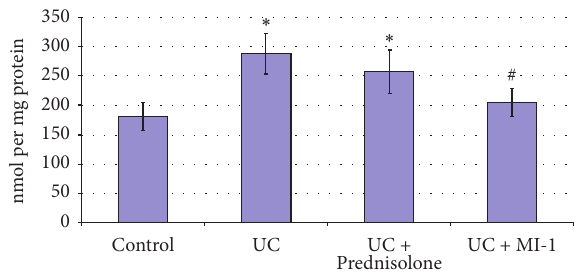
Figure 8: Bowel mucosa PCG concentrations for rats experiencing UC and treated with Prednisolone and MI-1. ∗ 𝑝 ≤ 0.05 compared with control group; # 𝑝 ≤ 0.05 compared with UC